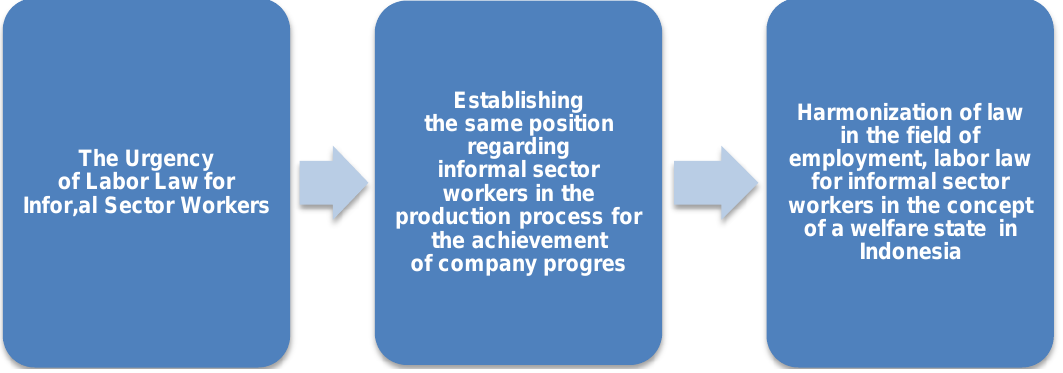
Figure 1: The Urgency of Labor Law for Informal Sector